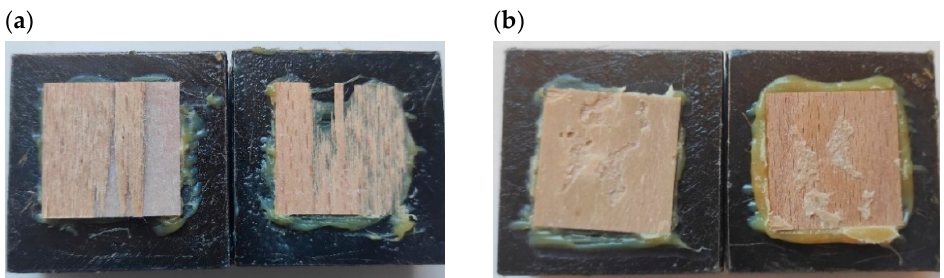
Figure 6. Internal bond (IB) results of tested five-layer composites.